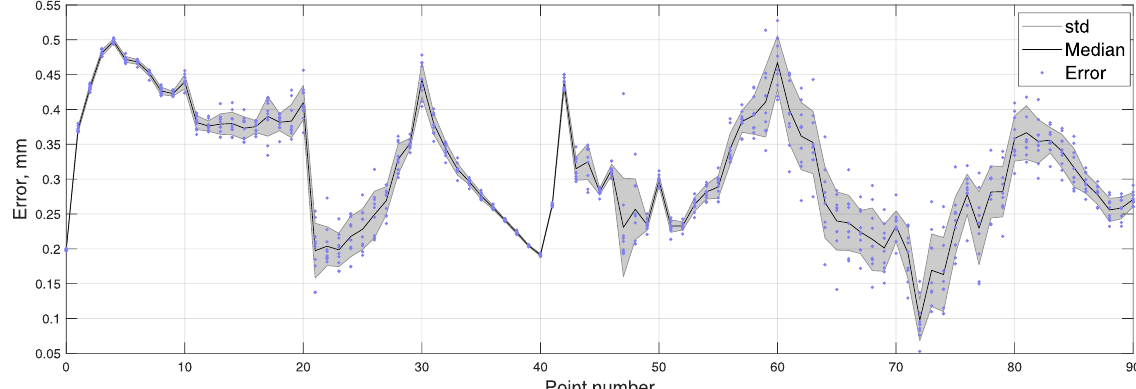
Figure 10. Error of every measured point in 10 iterations of cubic test trajectory, with median and standard deviation. The coordinates of masticatory test trajectory were determined 10 times, resulting in an average RMSE and standard deviation equal to 0.260 ± 0.004 mm. BMF was compensated using a reference magnetometer. Measured points are numbered 0 to 62, and all 10 iterations are represented in transparent markers in Figure 11. To show error and reproducibility of 10 iterations, the median and standard deviation for each point are presented in Figure 12, with points showing errors of each measurement.